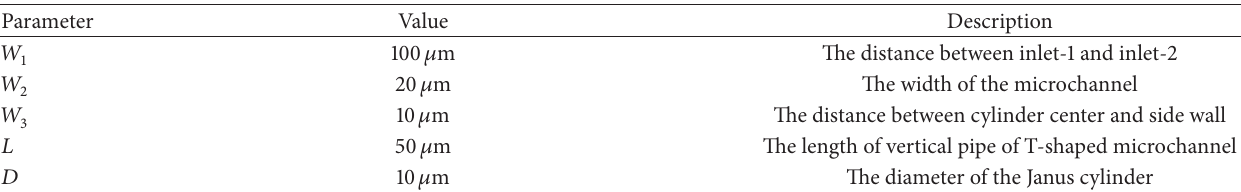
Figure 3: Schematic diagrams of induced zeta potential distribution on the polarizable particle’s surface. 𝐸 0 = 42.76 KV / m, 𝑟 = 20 𝜇 m. Table 1: Model